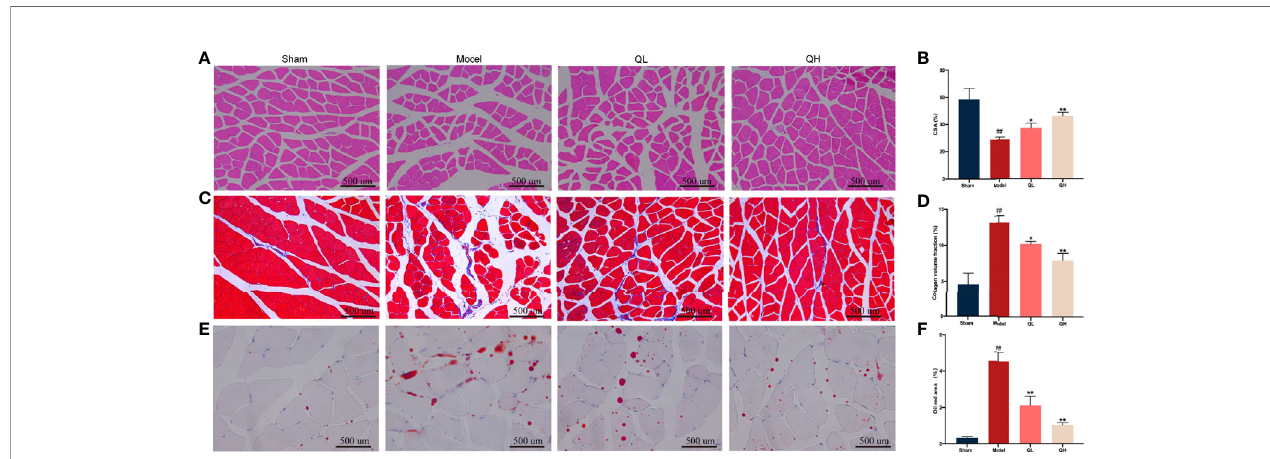
FIGURE 5 | Effects of quercetin on morphological changes in the gastrocnemius muscle of mice that underwent orchiectomy. (A) Morphological changes in the gastrocnemius, visualized by H&E staining, and (B) changes in the average cross-sectional area of myo fi bers (CSA). (C) Masson ’ s staining of the gastrocnemius muscle, and (D) changes in the collagen fi ber area. (E) Oil Red O staining of the gastrocnemius muscle, and (F) the changes in the area of the lipid droplet. ## p< 0.01 vs. sham group; * p< 0.05, ** p< 0.01 vs. model group.